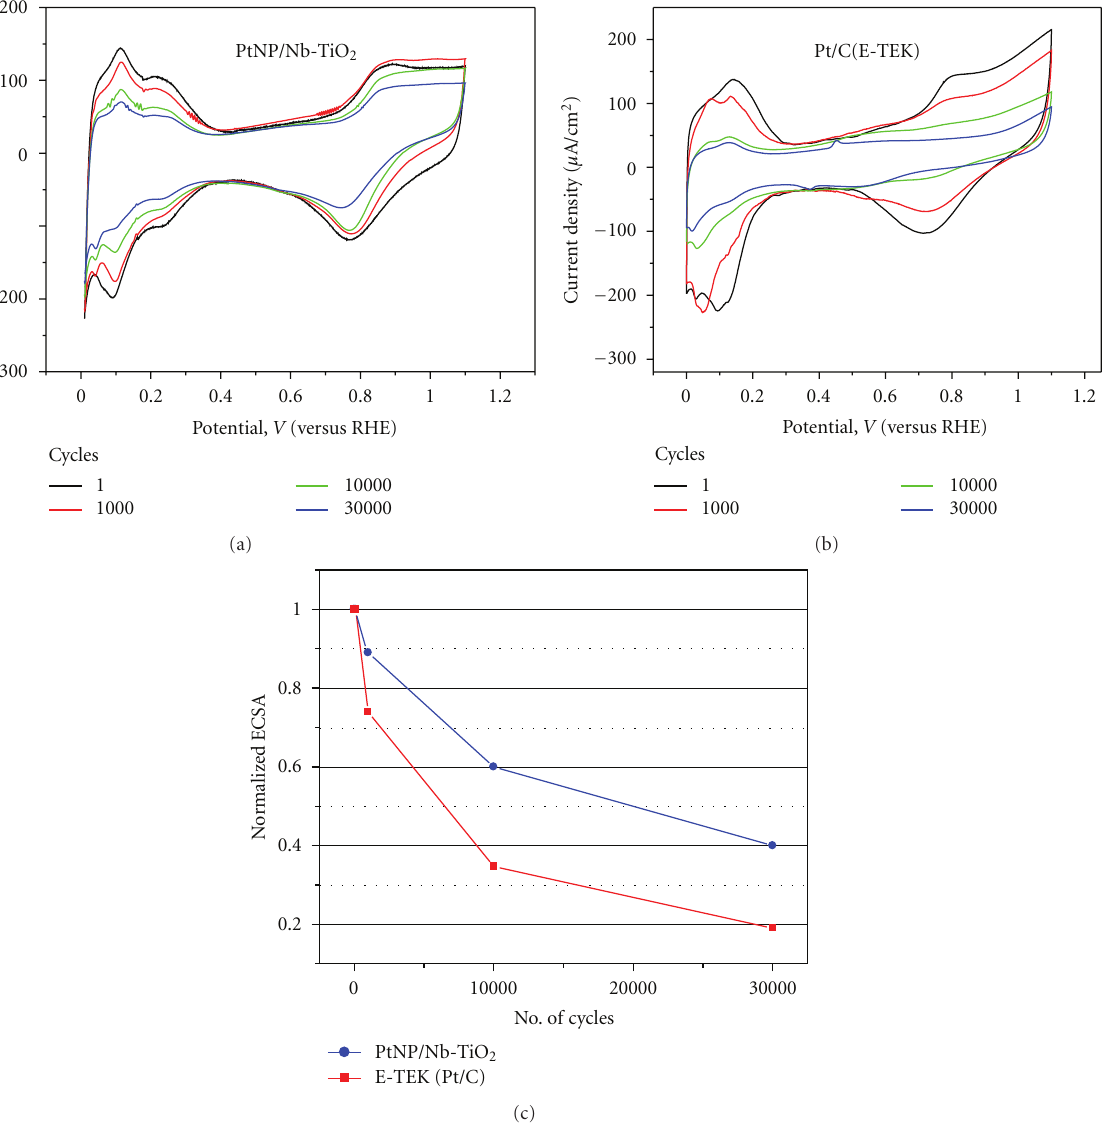
Figure 6: Cyclic voltammograms recorded on (a) PtNP/Nb-TiO 2 and (b) ETEK PtNP/C electrodes in 0.1M HClO 4 solution at room temperature during ADT. (c) ECSAs as a function of cycling numbers on PtNP/Nb-TiO 2 and ETEK PtNP/C